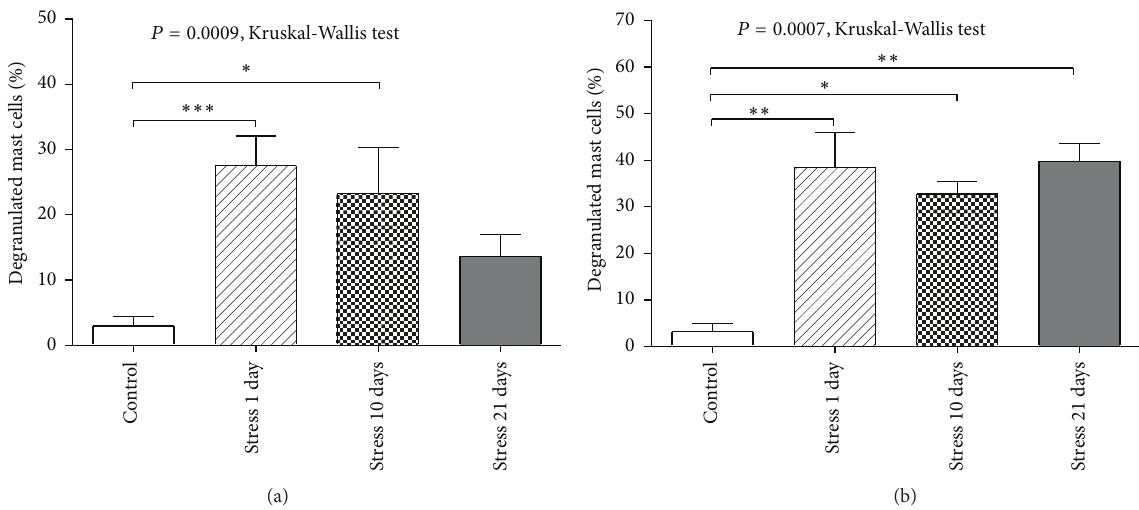
Figure 3: Comparative analysis of the proportion of degranulated mast cells. (a) In glabrous skin, brief exposure to stress induced a significant increase in the proportion of degranulated mast cells and prolonged exposure to stress was associated with a gradual return to normal value of degranulated mast cells. (b) In hairy skin, acute exposure to stress induced an amplification of mast cell degranulation process that was maintainedafterprolongedexposuretostress.Errorbarsrepresentthestandarderrorofthemean(SEM). ∗ 𝑃 < 0.05 , ∗∗ 𝑃 < 0.01 , ∗∗∗ 𝑃 < 0.001 , two-tailed multiple comparison test.